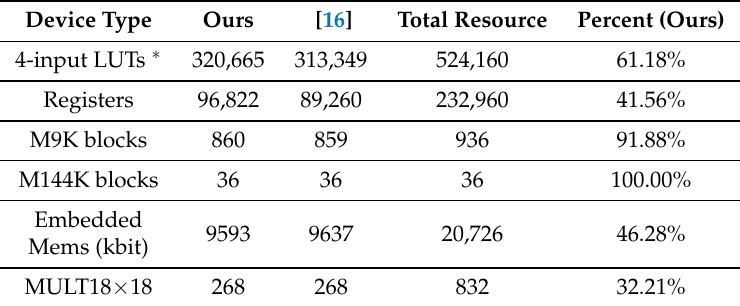
Table 1. Resource consumption of all